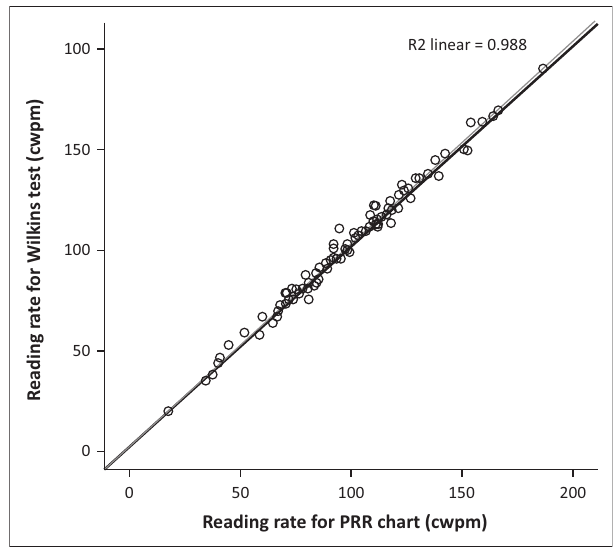
FIGURE 6: Scatter plot showing reading rate (correct words per minute) test (R1) and retest (R2) with paediatric rate of reading and Wilkins tests. R1 and R2 measurements show a strong correlation ( r =